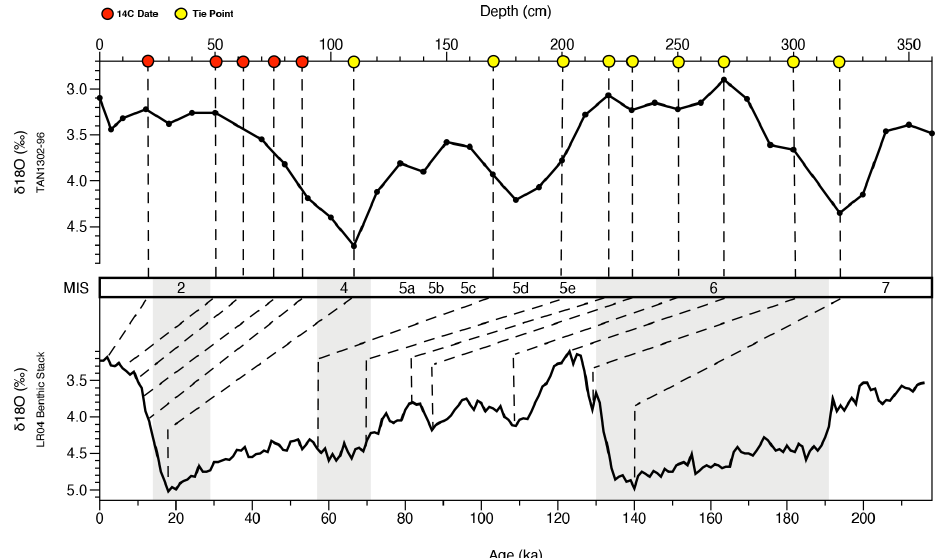
Figure 2. Age model of TAN1302-96. Red circles indicate the depth of AMS 14 C samples, and yellow circles indicate tie points between the TAN1302-96 oxygen isotope stratigraphy and the LR04 benthic stack (Lisiecki and Raymo, 2005). Two radiocarbon dates, OZX 519 and 520 (at 130 and 170cm, respectively), were not included in the age model as they produced dates that were NDFB (not distinguishable from the background).